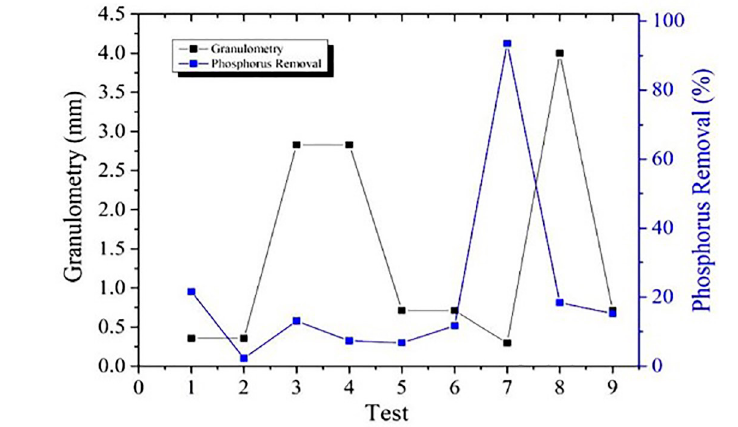
Figure 12. Profile of percentage reduction of phosphorus content as a function of the mean particle size of iron ore